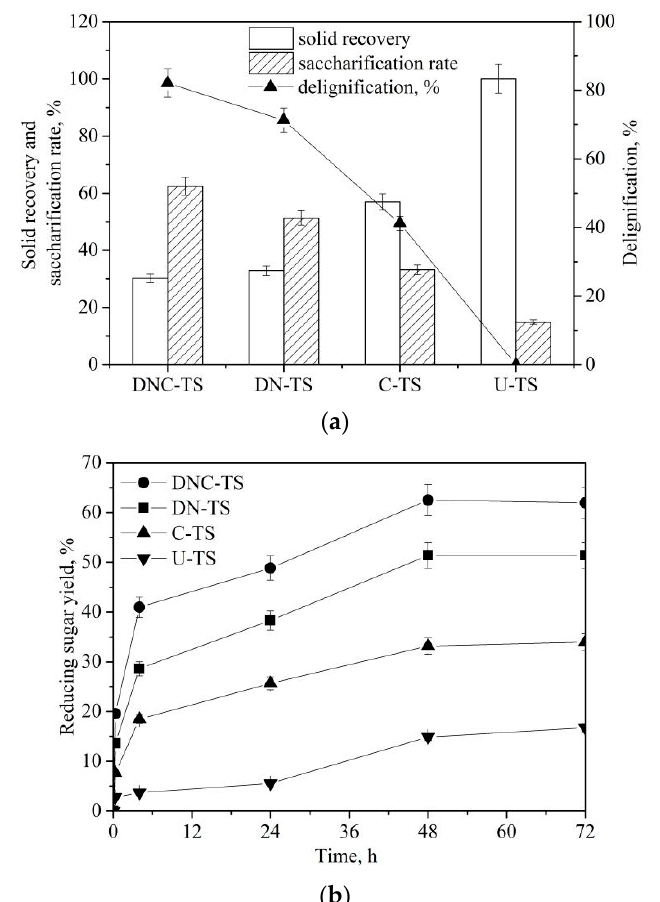
Figure 5. Effects of dilute NaOH (7 wt%), ChCl:UA-TA and their combination (dilute NaOH– ChCl:UA-TA) on the pretreatment and enzymatic saccharification of TS [Pretreatment condition: NaOH (7 wt%)–ChCl:UA-TA (1–16 wt%), 75 °C, 60 min; Enzymatic hydrolysis condition: cellulase (10.0 FPU/g TS) and xylanase (30.0 CBU/g TS), 50 °C, pH 4.8] ( a ); Time courses for the enzymatic